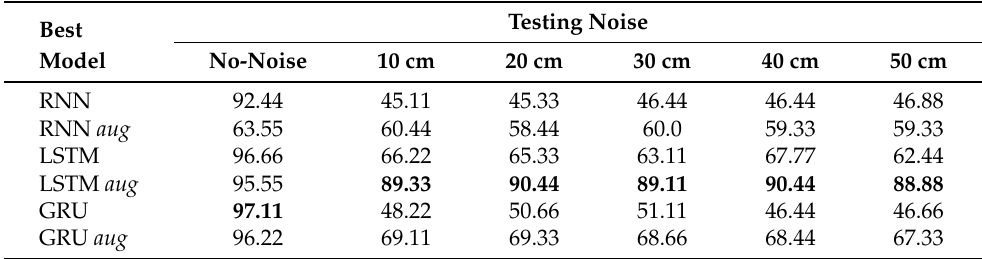
Table 5. Classification accuracy of the best model variation of each architecture evaluated on noisy testing data. The names ending with aug refer to a model augmented during training with Gaussian noise on the inputs of zero mean and standard deviation of 30 cm. Every column represents a test set with a different noise level. The best result on each column is highlighted in bold.